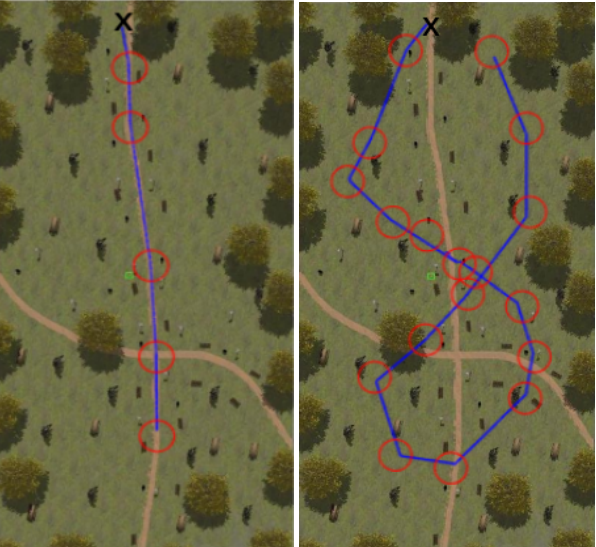
Figure 8. Paths followed during data acquisition in the park environment.